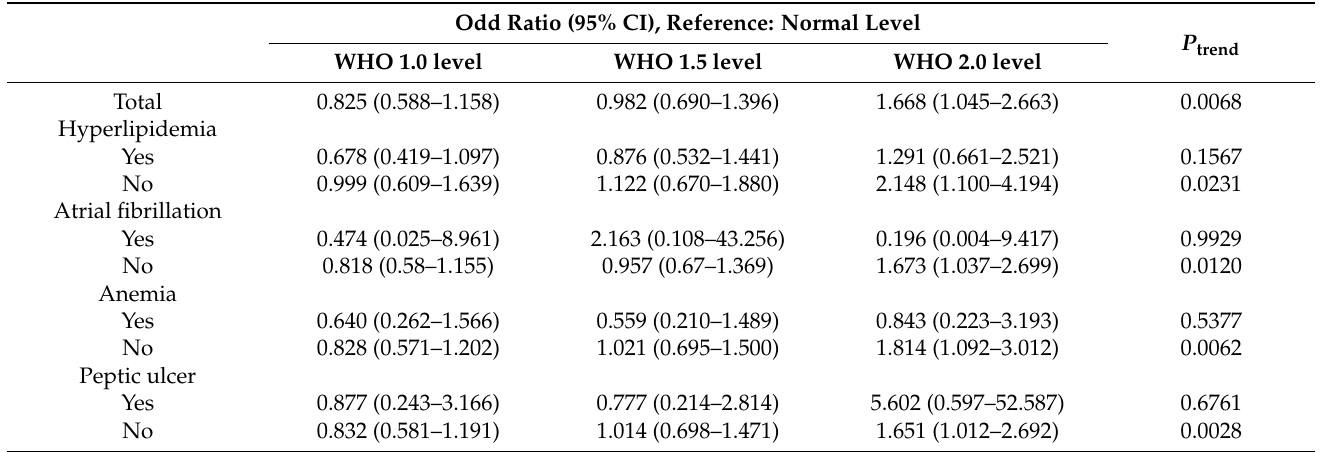
Table 4. Logistic regression analysis of PM 2.5 level and POAG in